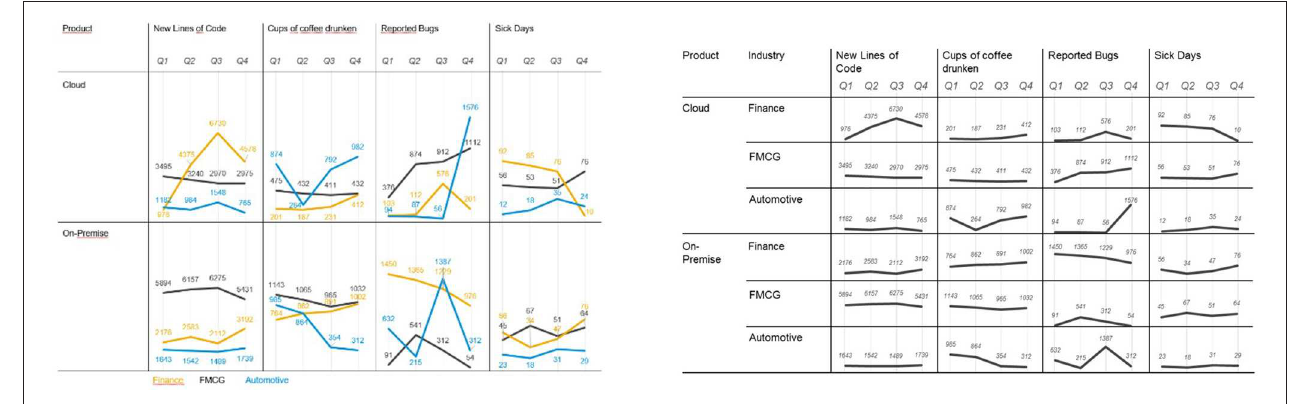
FIGURE 7 | Two visualizations displaying the same data set for an analysis setting (left) and a monitoring setting (right)